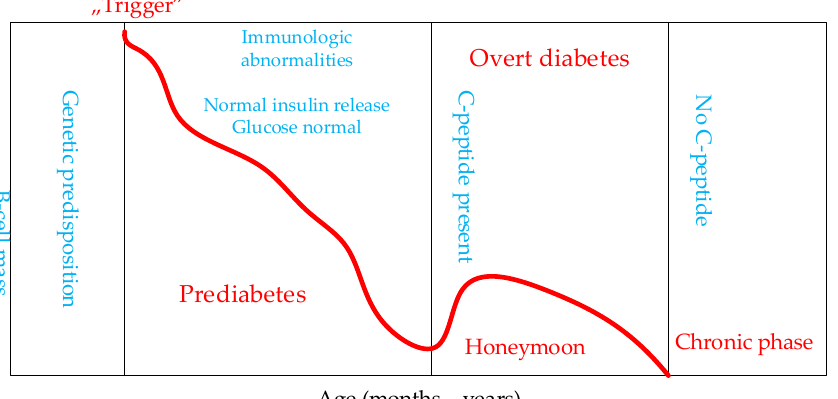
Figure 1. Stages in the development of type 1 diabetes mellitus. Phase 1 is the preclinical phase with the development of antibodies (ICA, IAA, GAD, ZnT8). Phase 2 is the preclinical phase which can last for months and years. Phase 3 is the onset of clinical diabetes with transient remission (“Honeymoon”). Phase 4 is clinically advanced diabetes with acute and chronic complications.